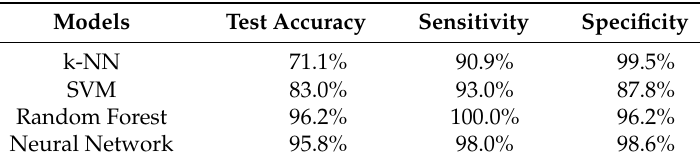
Table 4. Comparison of the performance of different detection